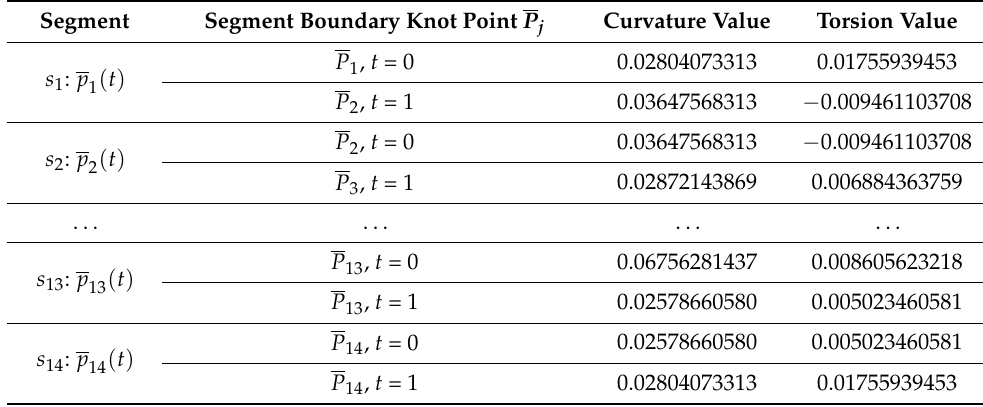
Figure 11. Closed fifth-degree Hermite spline curve of 14 segments.